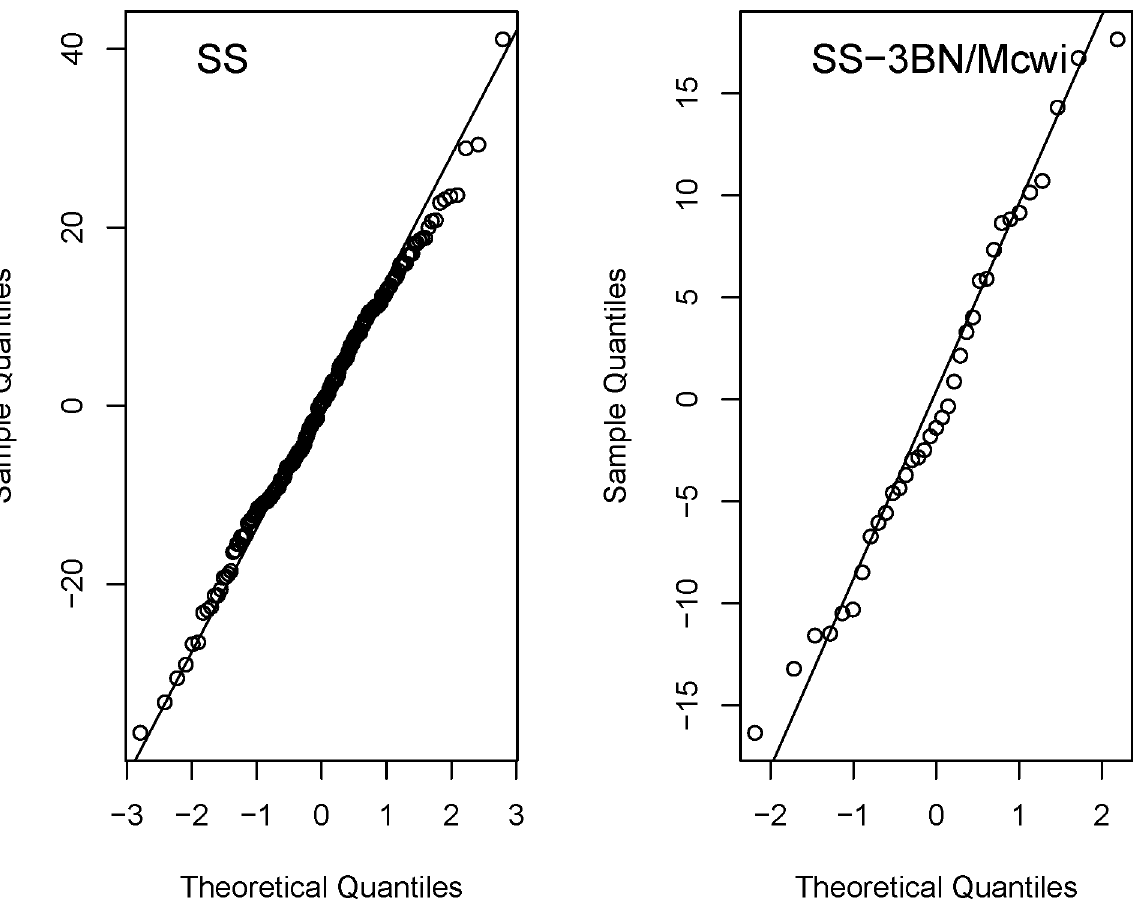
Fig 7. Example output of the PhenStat qqplotGenotype function. Data shown is the output from the qqplotGenotype function during the analysis of the ischemic peak contracture pressure from a study on rats comparing SS strain to SS-3BN/Mcwi strain when fitted with the Mixed Model method including body weight. This function allows an assessment of the model by examining the behaviour of the residuals, which is the difference between the measures and the model estimated values. A good model will have a normal distribution of residuals and the plot allows this to be assessed for each group being compared. Looking at the example, the residuals for both groups show no systematic deviations from the line indicating the model is fitting this data